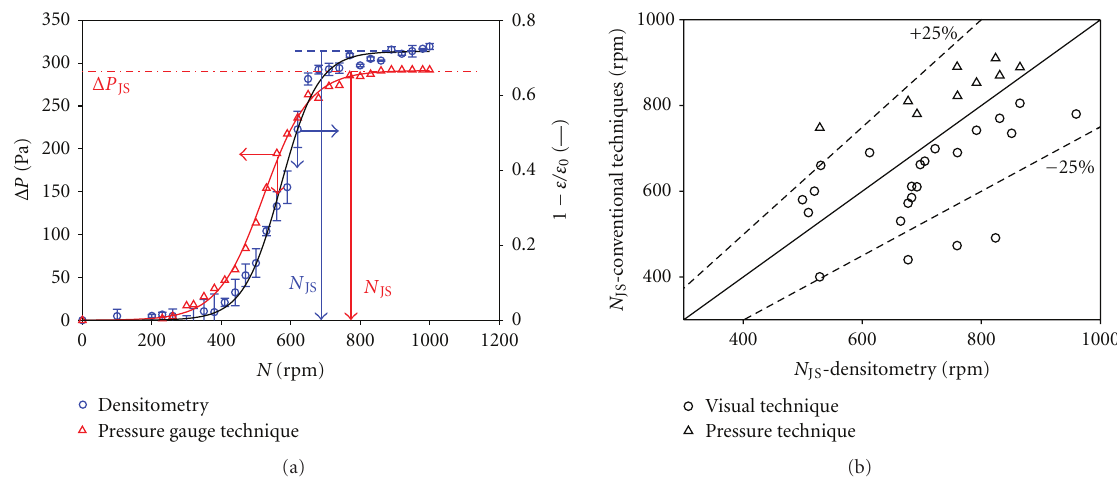
Figure 3: (a) Comparison of gamma-ray densitometry technique with pressure technique. (b) Comparison of gamma-ray densitometry technique with two conventional